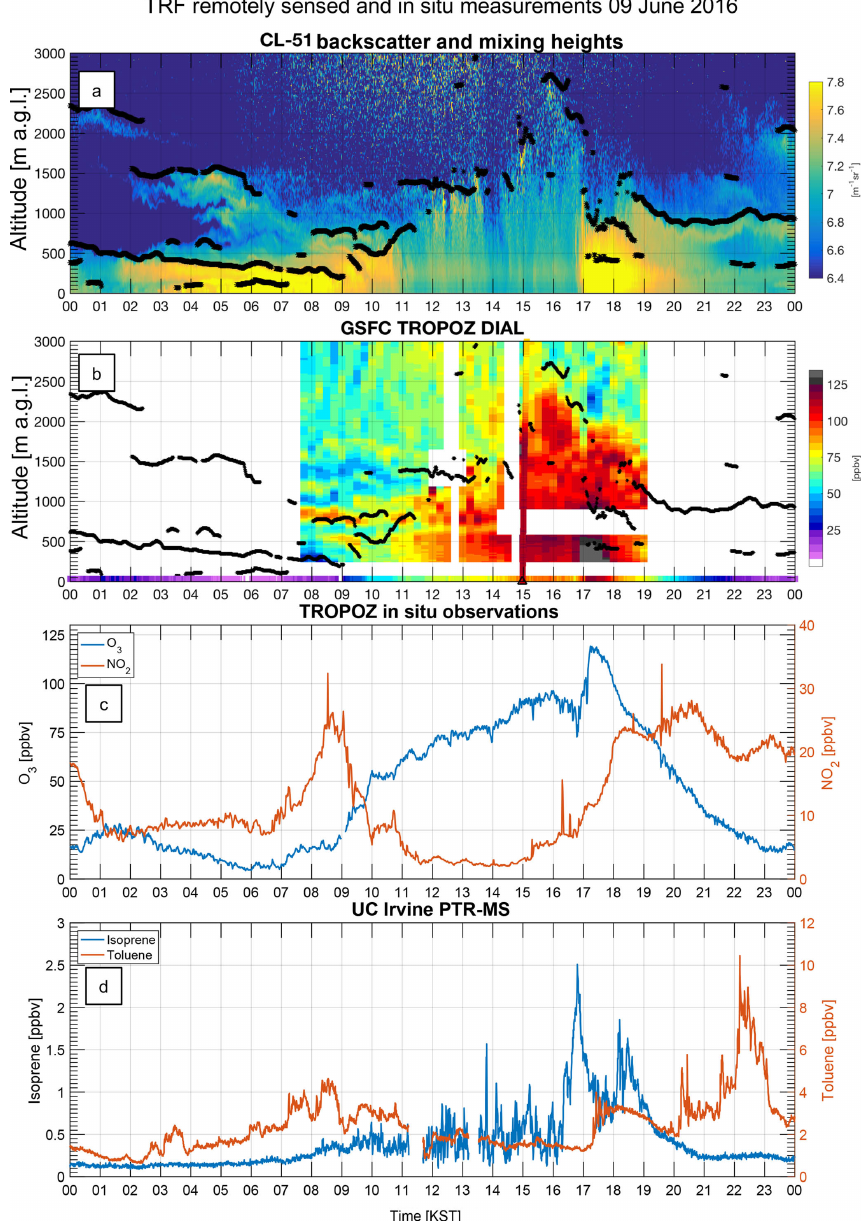
Figure 10. Time series of (a) ceilometer backscatter profiles and mixing heights, (b) GSFC TROPOZ DIAL O 3 profiles, (c) in situ surface O 3 and NO 2 , and (d) isoprene and toluene concentrations for 9 June 2016. Note: the DC-8 overpass occurred near 15:30KST. The colocated ozonesonde is denoted in (b) with a black